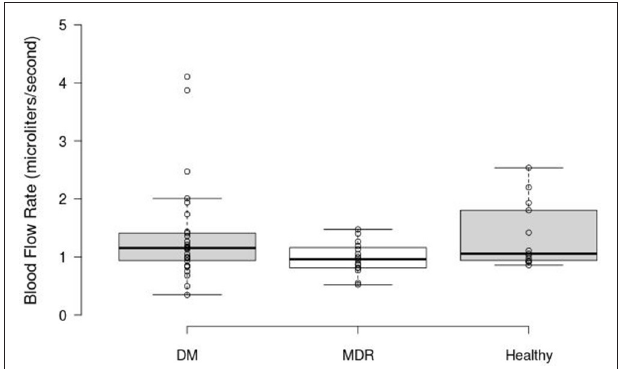
FIGURE 4 | Box Plot displaying the BFR results obtained for the overall blood vessels in the three study groups. The middle 50% of the data groups are